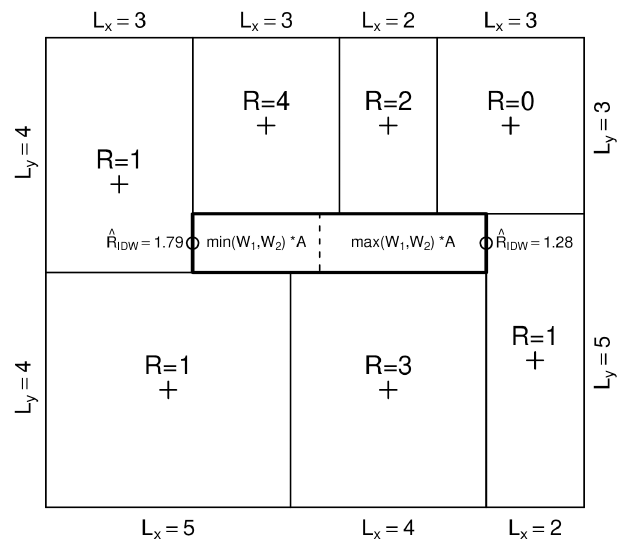
Figure 2. Illustration of the splitting rule for a single grid cell (in bold at the center of the figure), with area A surrounded by seven grid cells with different areas and intensities. Grid cells are always split perpendicularly to their longest dimension (i.e., vertically in this case). The inverse-distance interpolated rainfall rates ˆ R IDW on the left and right sides of the grid cell (or equivalently, at the top and bottom for horizontal splits) are used to determine which side receives the highest rainfall intensity during the split (i.e., the left side in this case). The weights W 1 and W 2 = 1 − W 1 are drawn at random from a fixed distribution